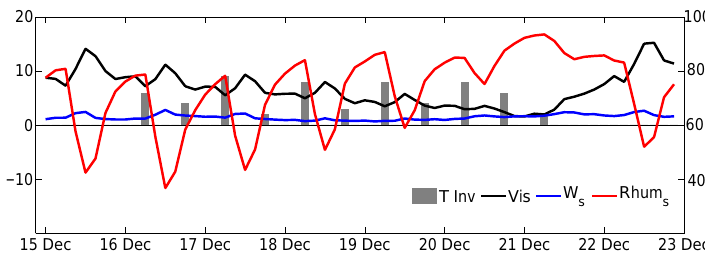
Figure 5. The variation of area-mean visibility (black), surface wind speed (blue), and surface relative humidity (red, right y -axis). The intensity of the temperature inversion ( T 925 – T 1000 ) in Beijing is shown as a gray bar.